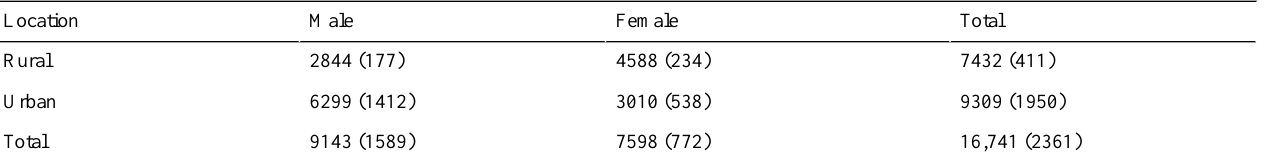
Table 2. The number of subjects by sex and location (the number of subjects who participated in both the 2012 and 2013 checkups are indicated in